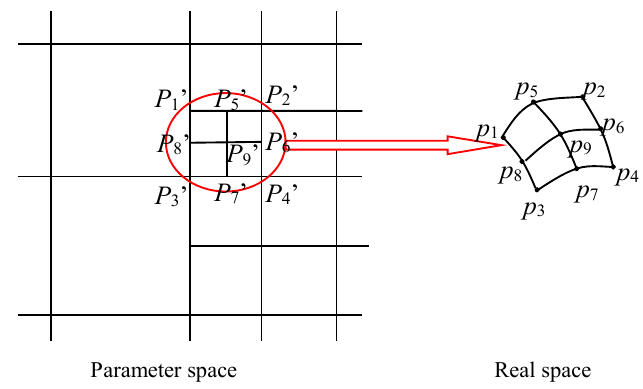
Figure 5. According to the distance in real space the point cloud is generated.